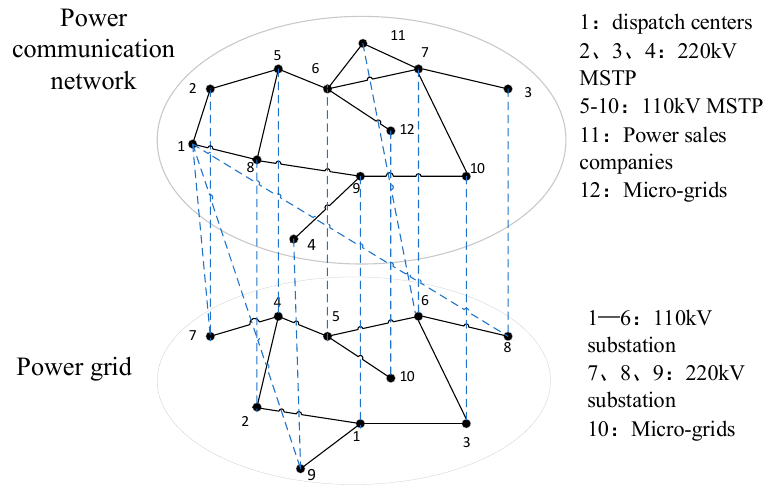
Figure 1. Dual ‐ network coupling model. Figure 1. Dual-network coupling